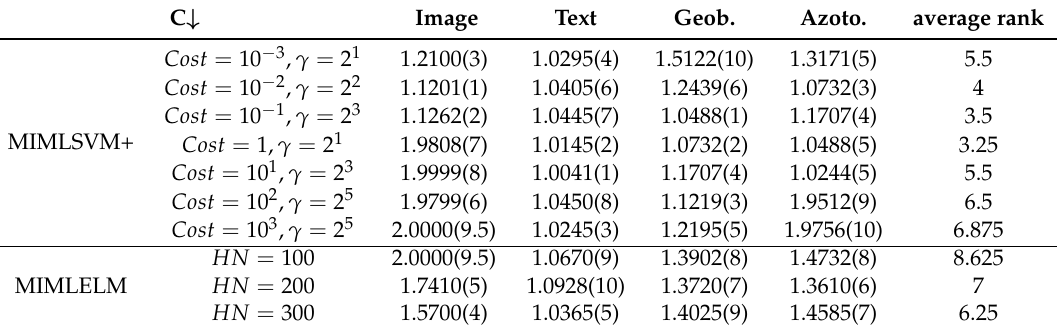
Table 12. Friedman test of the effectiveness comparison in Tables 2–5 on criterion C .